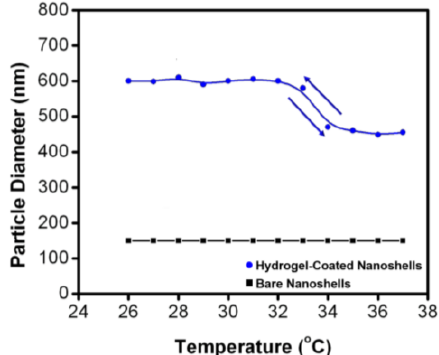
Figure 21. Variation of the hydrodynamic diameter of bare and hydrogel-coated gold nanoshells as a function of temperature, determined using Dynamic Light Scattering (DLS) [142].